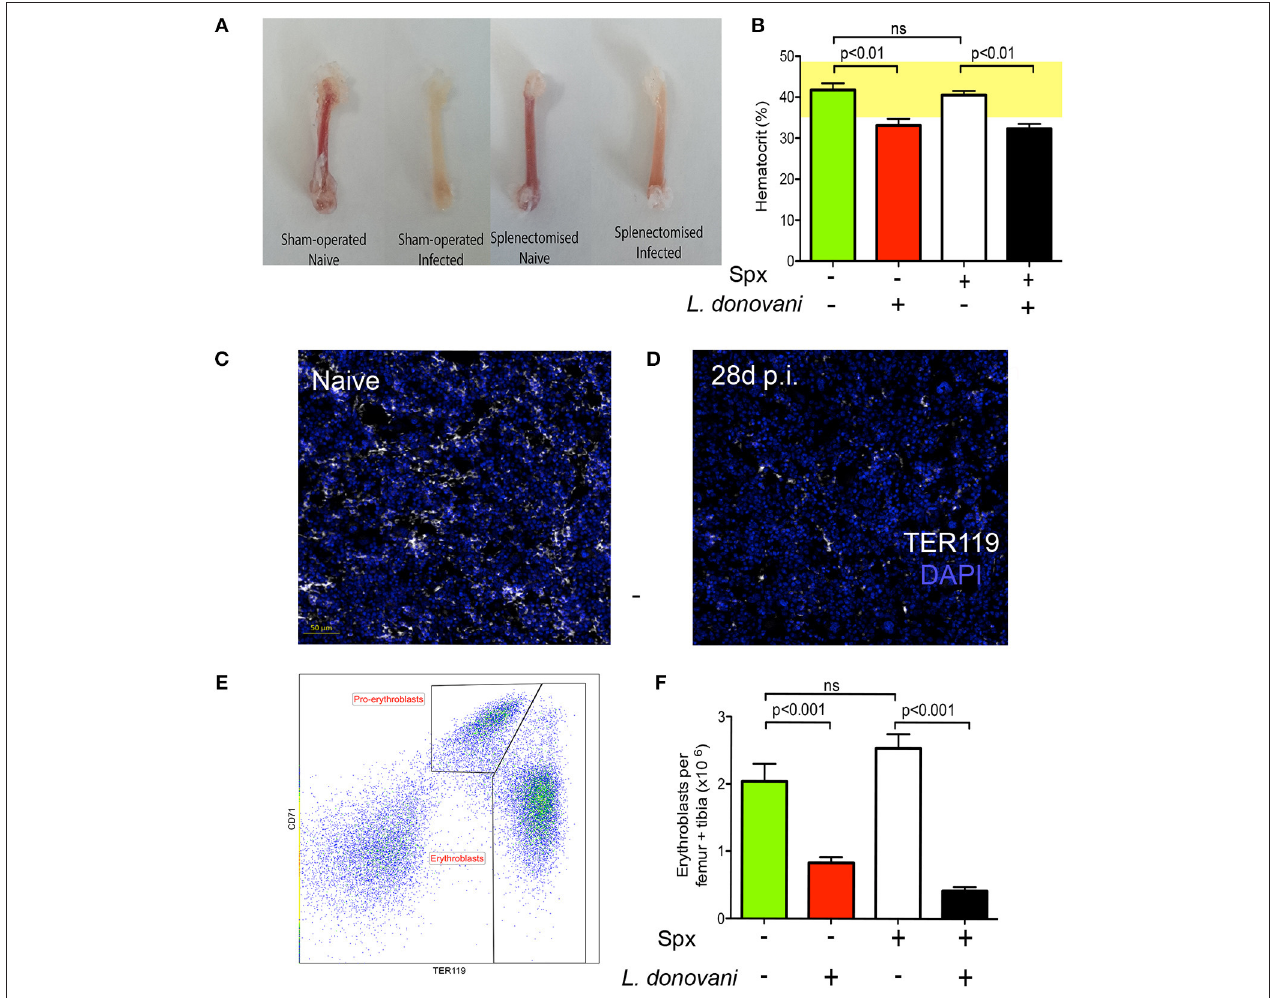
FIGURE 2 | Medullary erythropoiesis is repressed during experimental visceral leishmaniasis. (A) Femurs isolated from L. donovani -infected mice and age-matched naïve mice. Representative from 30 mice per group from 10 independent experiment. (B) Hematocrit in naïve and infected mice with and without splenectomy (Sp x ). (C,D) Confocal imaging of 5 µ m-thick femoral sections from naïve (C) and infected (D) mice stained with DAPI (blue) and TER119 (white). Representative of six mice per group from two independent experiments. (E) Representative flow cytometry analysis of CD45 − BM cells from infected mouse using the erythroid surface markers CD71 (transferrin receptor) and TER-119. Pro-erythroblasts are CD45 − CD71 + TER119 low and erythroblasts are CD45 − CD71 − / + TER119 high . (F) Absolute number of pro-erythroblasts per femur + tibia in sham operated and Sp x mice. Mann Whitney test; n = 14 mice per group from four independent experiments. Data represent mean ± SEM. All experiments were performed 28 days